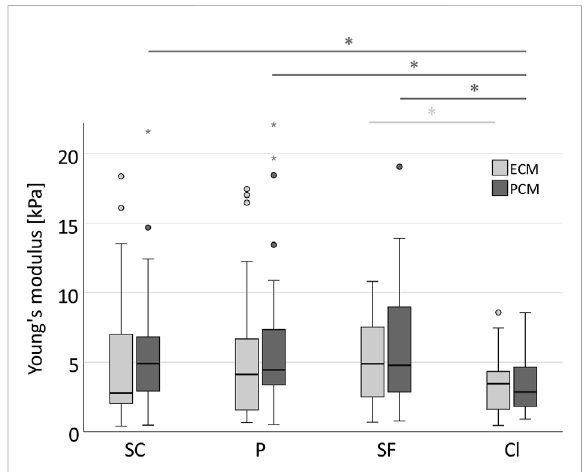
FIGURE 5 Stiffness in clusters is signi fi cantly reduced in the PCM compared to physiological spatial chondrocyte patterns. Boxplot displaying the Young ’ s moduli for the ECM (light grey) and PCM (dark grey) across the different spatial chondrocyte patterns inthehuman degenerate IVD. While measurementresults showed no difference between single cells, pairs, and string-formations, stiffness was signi fi cantly lower in chondrocytes arranged in clustersforthePCM(SC-Cl: p =0.026,P-CL: p =0.016,SF-Cl: p = 0.010). The values for the ECM in clusters failed to reach statistical signi fi cance with the exception of the difference between string- formations with clusters ( p = 0.022). No relevant difference was